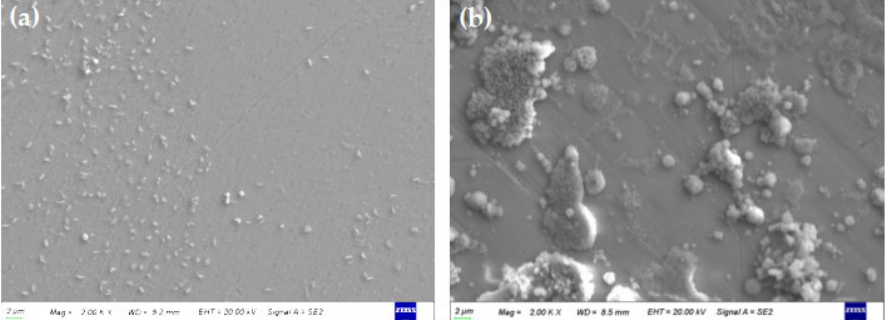
Figure 12. Microstructure after 14 days of corrosion in a 400 °C high-temperature and high-pressure water environment: ( a ) (FeNi) 67 Cr 15 Mn 10 Al 5 Ti 3 alloy; ( b ) Zr-4 alloy.